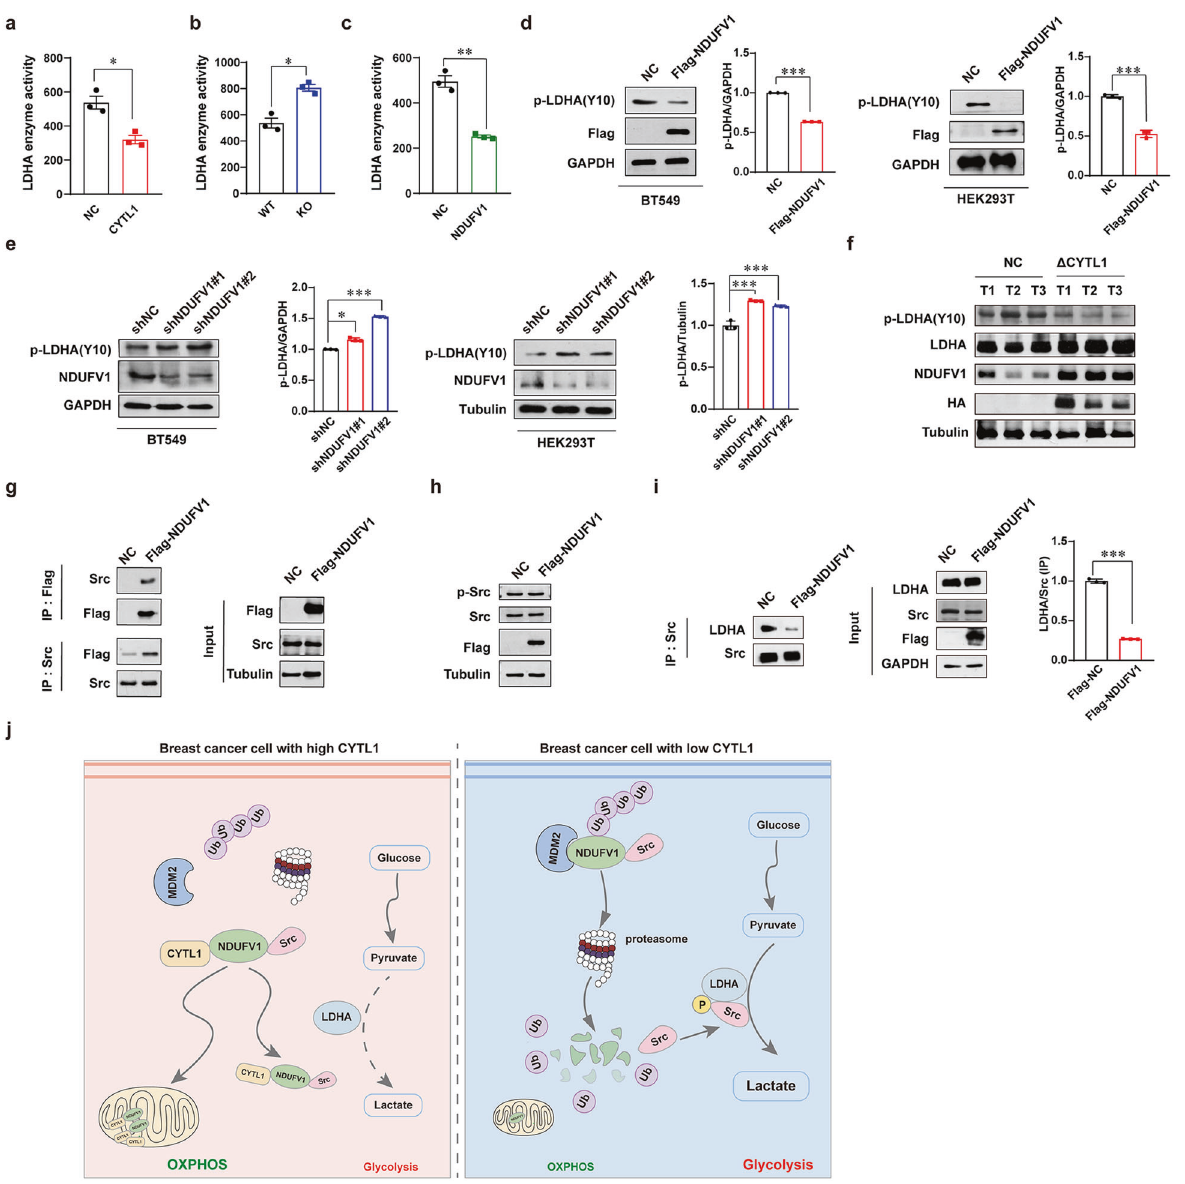
Fig. 6 NDUFV1 suppresses the Y10 phosphorylation of LDHA by Src. a LDHA enzyme activity in MDA-MB-231 cells overexpressing CYTL1 was detected using kit assay. b LDHA enzyme activity in CYTL1 KO cells. c LDHA enzyme activity in MDA-MB-231 cells overexpressing NDUFV1. d , e LDHA Y10 phosphorylation level was determined by western blot in the indicated cells transfected with d Flag-NDUFV1 expressing plasmids or e the shRNAs against NDUFV1. GAPDH was used as a loading control. f MDA-MB-231 orthotopic breast cancer models were established as described in Fig. 4. The indicated proteins in tumor tissues were determined by western blot. g Co-IP analysis of the interaction between Flag-tagged NDUFV1 and endogenous Src in transfected HEK293T cells. h The levels of phosphorylated Src and total Src were determined by western blot in MDA-MB-231 cells overexpressing NDUFV1. i Co-IP analysis of the interaction between Src and LDHA in HEK293T cells transfected with Flag-NDUFV1 expressing plasmids. j A schematic model for the role of intracellular CYTL1 in regulating metabolic reprogramming in breast cancer. The data are shown as the mean ± SD of three independent experiments. * P < 0.05, ** P < 0.01, *** P <